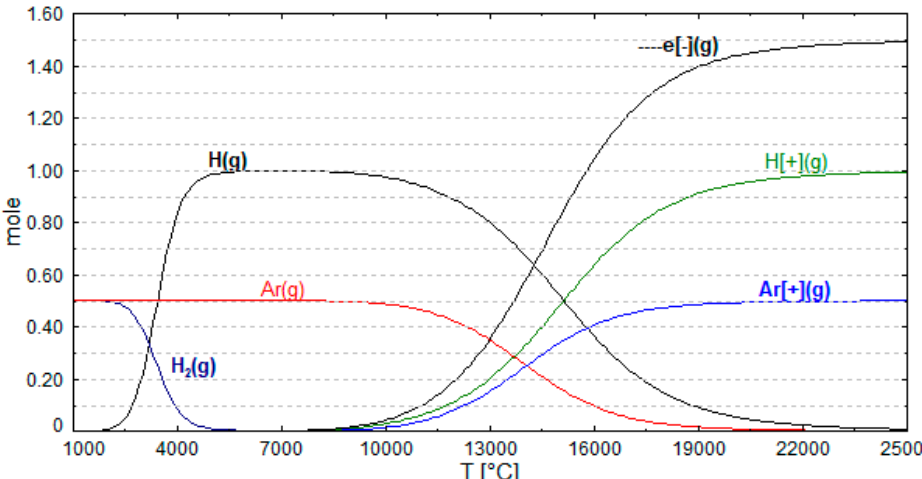
Figure 3. Gas composition of a H 2 -Ar mixture over the temperature at 100 kpa (FactSage™ 7.1, Database; FactPS 2017).